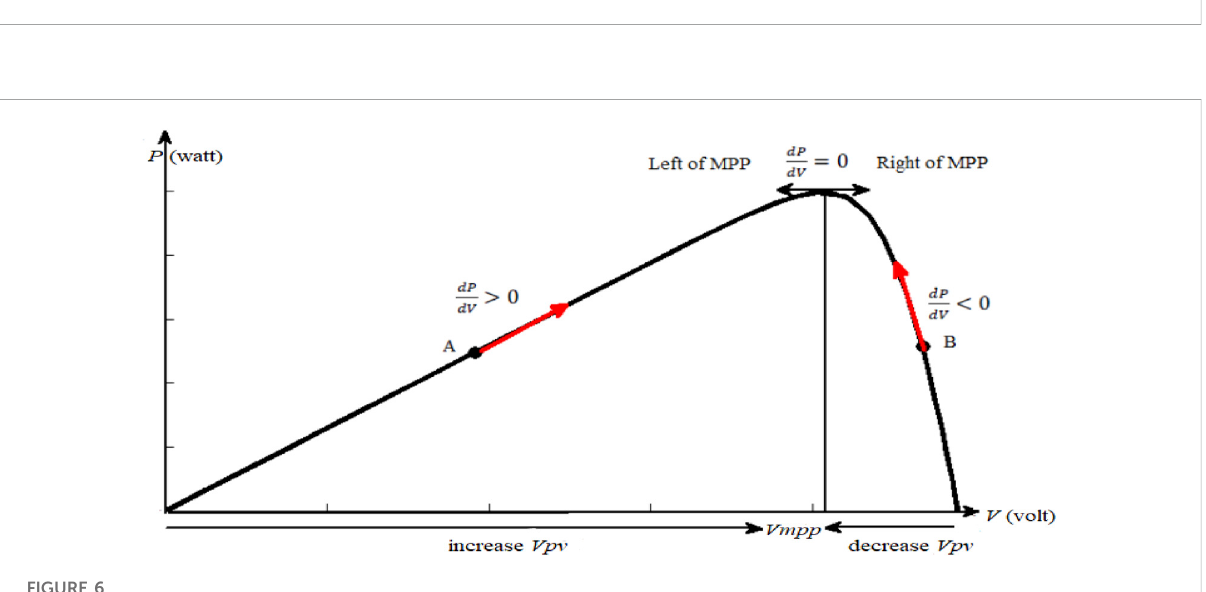
FIGURE 6 P&O on the P-V